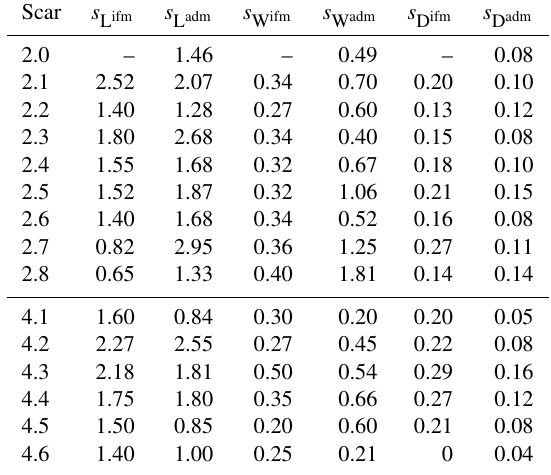
Table 1. Comparison of scar extents, length L , width W and depth D from in-field measurements and from the altitude difference map denoted with superscripts ifm and adm respectively. Error estima- tion for both techniques amount to ±